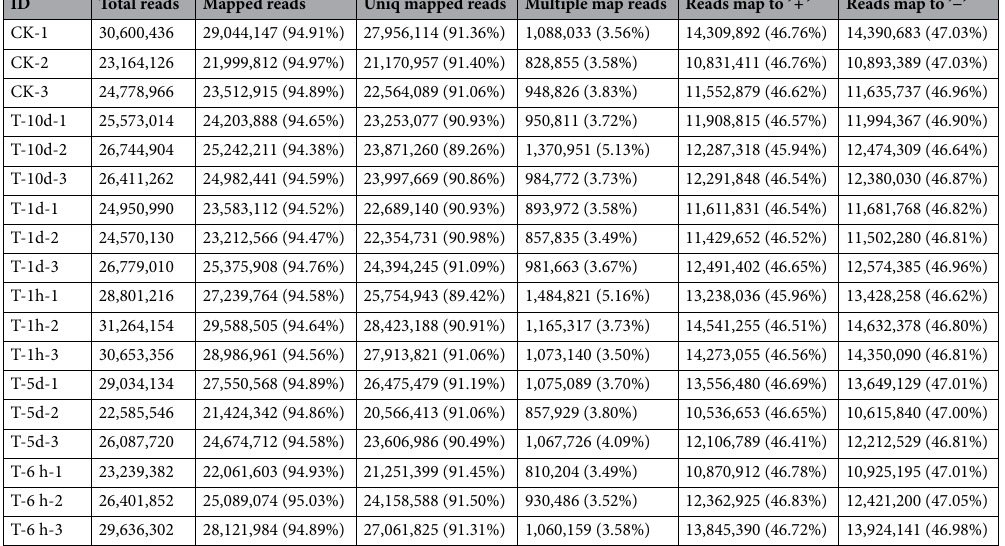
Table 2. Alignment results of each